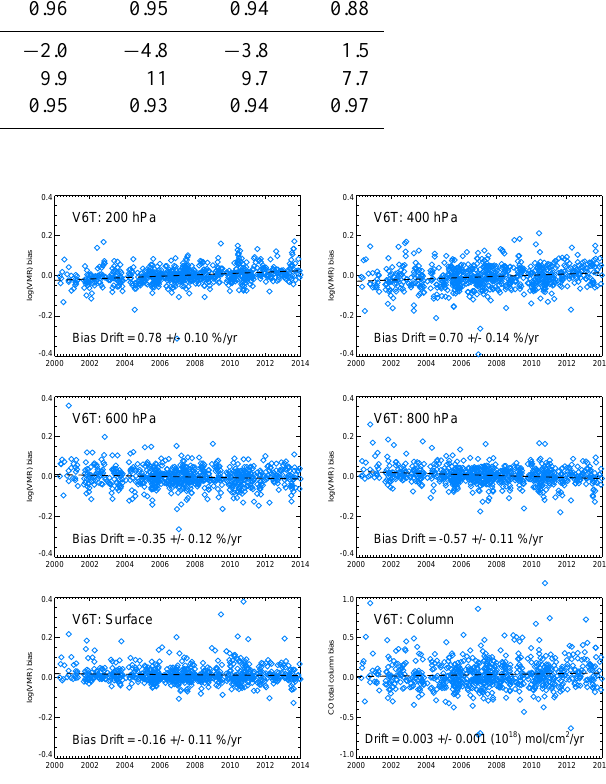
Figure 6. Scatterplots showing V6 TIR-only (V6T) validation re- sults based on HIPPO profiles. See caption to Fig. 3. Results for each of the five phases of HIPPO are color-coded as indicated in the top left panel.